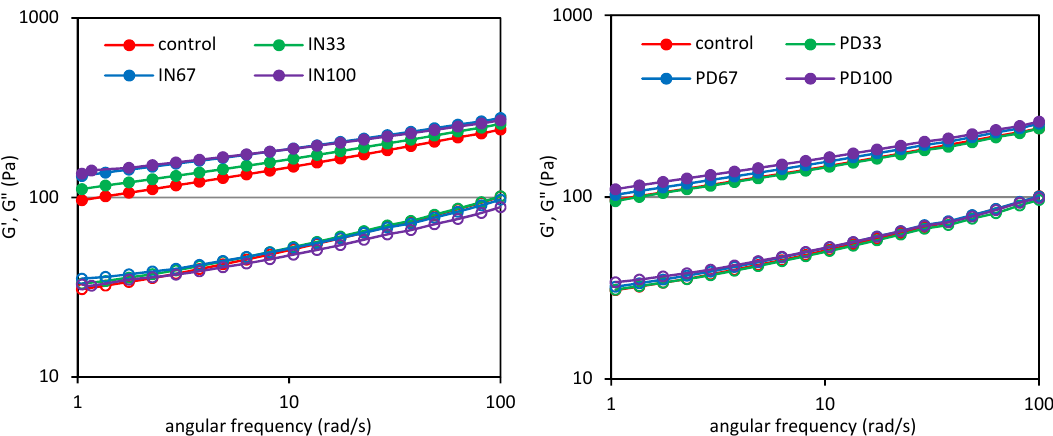
Figure 4. Sweep frequency curves of potato starch based desserts: without steviol glycosides (control), with inulin (IN33, IN67, IN100), with polydextrose (PD33, PD67, PD100); G’ ‐ filled markers, G” – empty markers.